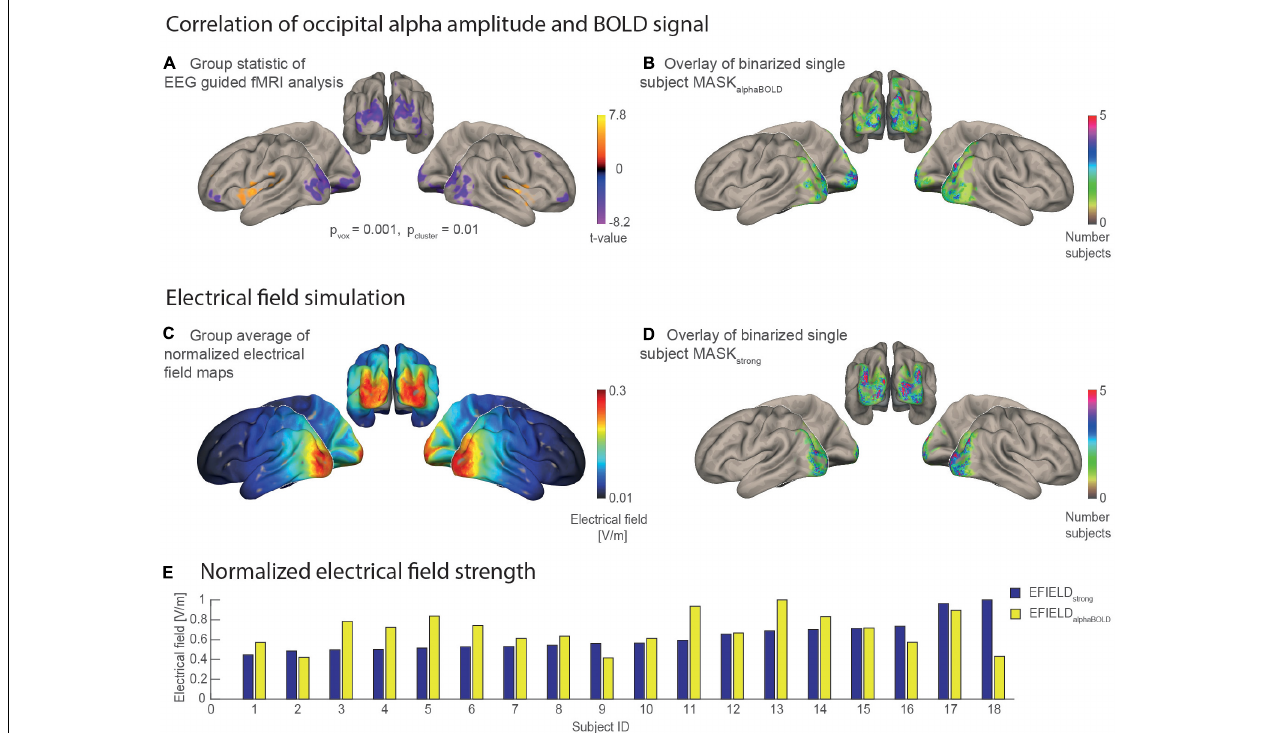
FIGURE 4 | Statistical maps and masks resulting from the EEG guided fMRI analysis and the electrical field simulations mapped on the MNI brain. (A) Result of the group statistic calculated for the EEG-guided fMRI analysis shows the spatial distribution of positive and negative correlations between alpha amplitude and BOLD [ n = 18, p (voxel level) = 0.001, p (cluster, fdr corrected) = 0.01]. (B) Overlay of 18 binary single subject masks, each covering 1,000 occipital voxels with the individually highest alpha BOLD correlation ( t -value). The color scale codes the number of individual masks that cover the same region. (C) Grand average of the individual electrical field simulations ( n = 18). (D) Overlay of 18 binary single subject masks that each cover a region with the 1,000 highest electrical field values. (E) Bar plot for the electrical field strength values of each subject that was determined as an average of simulated electrical field values covered by a subject-specific mask. EFIELD strong (blue) is sorted in ascending order.